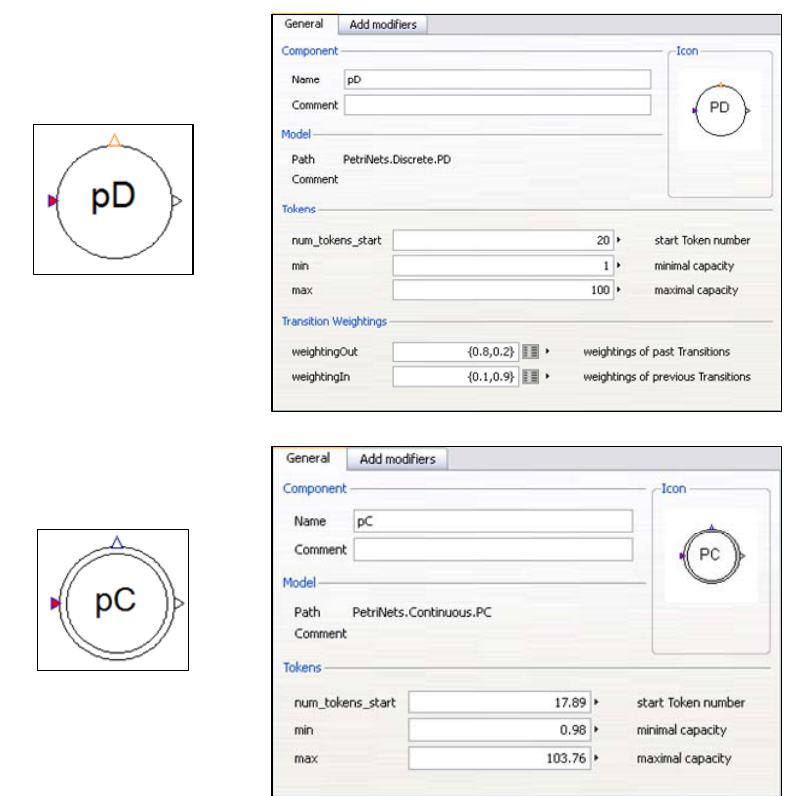
Figure 8: Property dialogs of discrete and continuous Places.